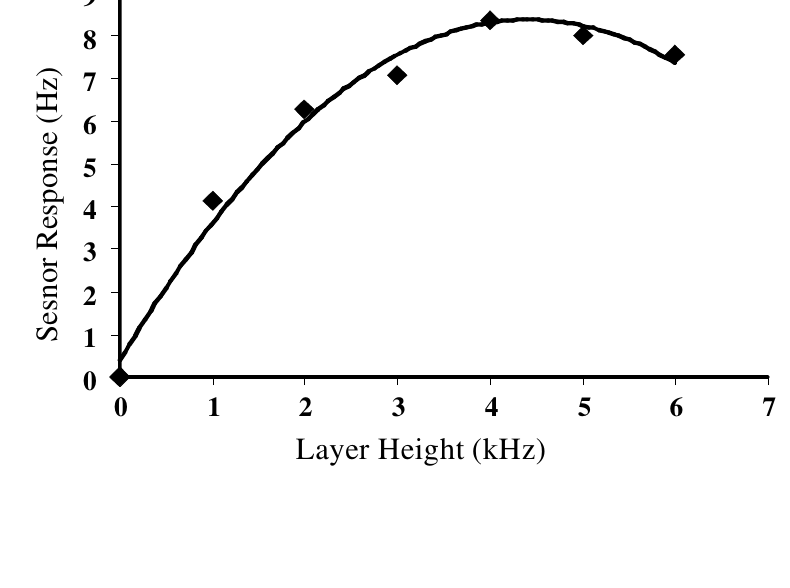
Figure 2. Variation of sensor response with changing layer heights of terpinene MIP at 50